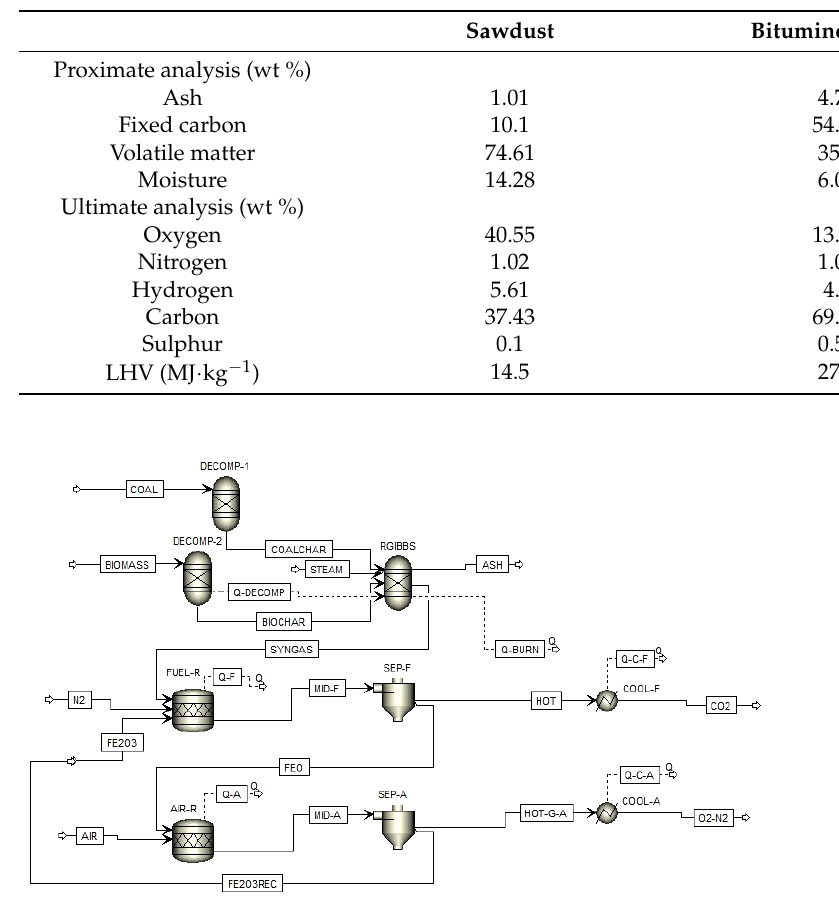
Figure 2. Component arrangement for CLC of coal/biomass mixtures. Two RYIELD reactors along with RGIBBS and RSTOIC reactors together performed the process carried out in the experimental fuel reactor. This was due to the fact that not all of the mentioned processes, such as the pyrolysis of the fuel particles, gasification of the char particles and combustion of the same, cannot be modeled explicitly as a single Aspen Plus component.